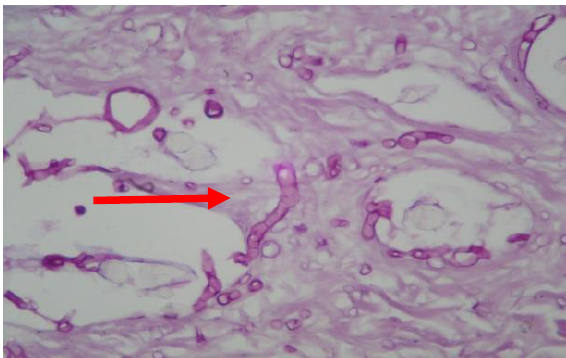
Figure, 11: Section in the skin of immunized animal at day 14 post challenge show ed proliferation of dermal collagen fiber with appearance of young fibroblast (H&E stain 400X).